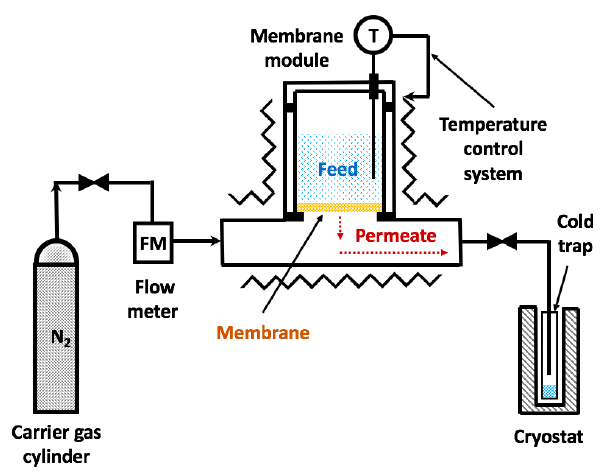
Figure 3. Scheme of the pervaporation set-up.